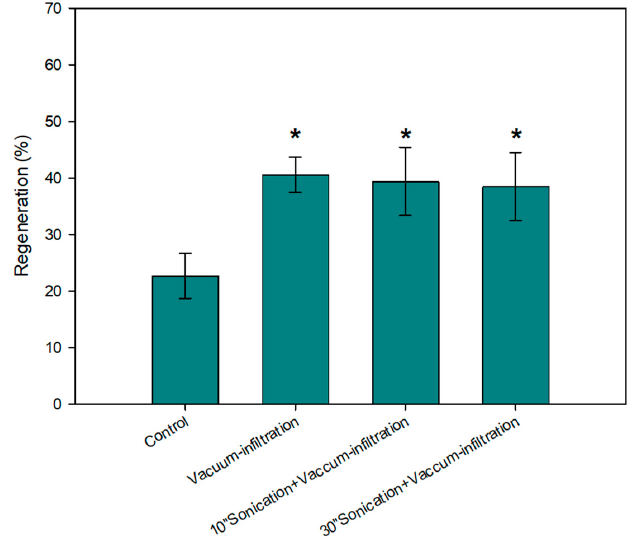
Figure 4. Effect of sonication treatments combined with 20 min of vacuum-infiltration on adventitious shoot regeneration from hypocotyl slices of non-infected ‘Canino’ mature seeds and infected with Agrobacterium harboring the plasmid pMOG-eyfp-IV2. Data were collected six weeks after the beginning of the experiments. Asterisks denote significant differences in regeneration percentages with the control according to specific contrasts ( p < 0.05) within infected